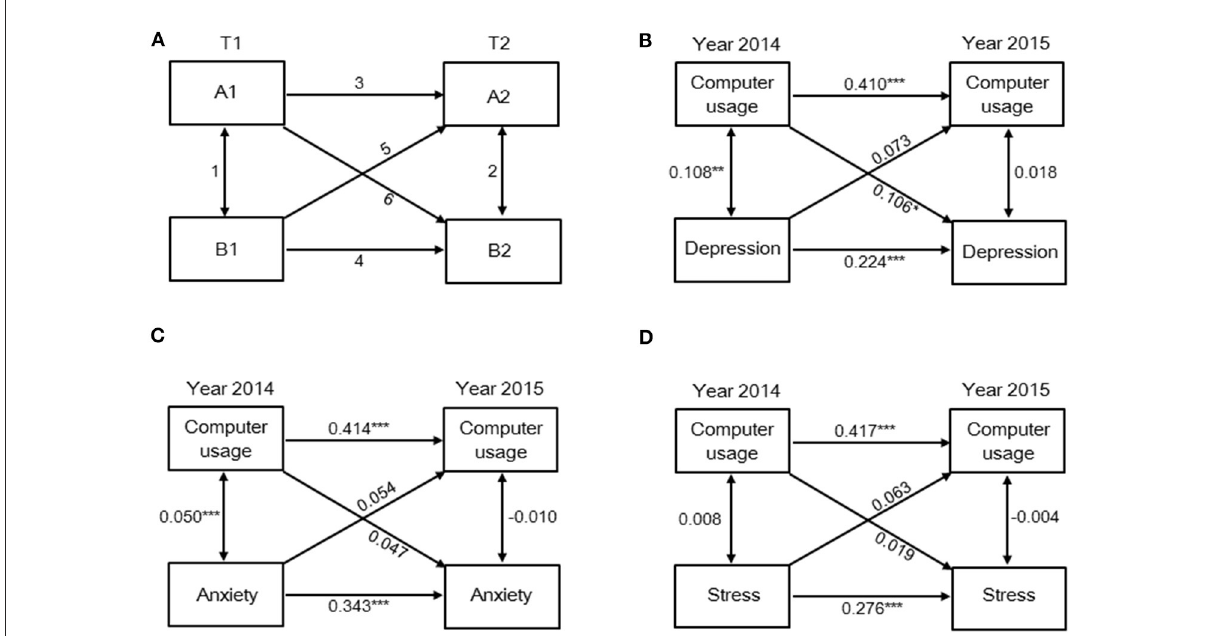
FIGURE2 Computer usage time is a predictor of depression status but not anxiety and stress status a year later. (A) Cross-lagged correlational model describing three types of relationships: 1, 2 = synchronous correlations; 3, 4 = autocorrelations; 5, 6 = cross-lagged correlations. Prospective associations between computer usage time and status of (B) depression, (C) anxiety, and (D) stress on the DASS-21. * p < 0.05, ** p < 0.01, and *** p < 0.001.